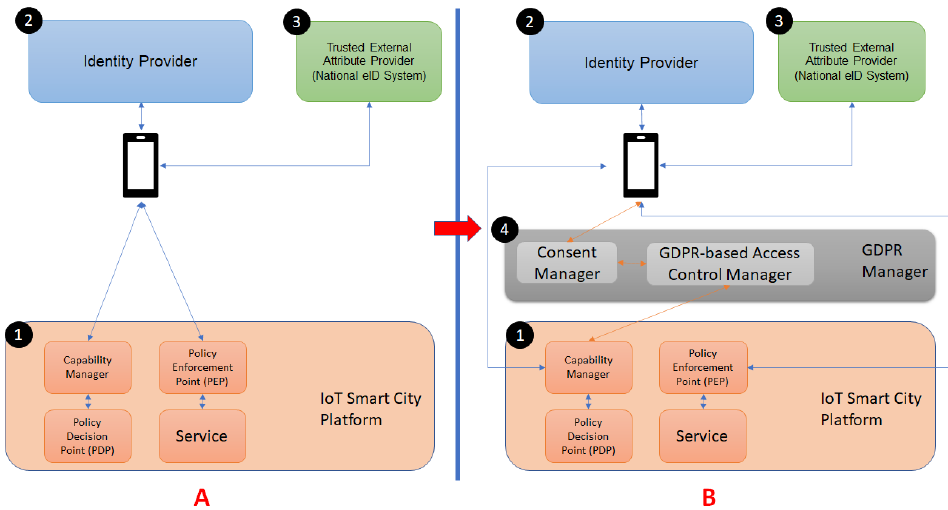
Figure 1. Privacy-By-Design